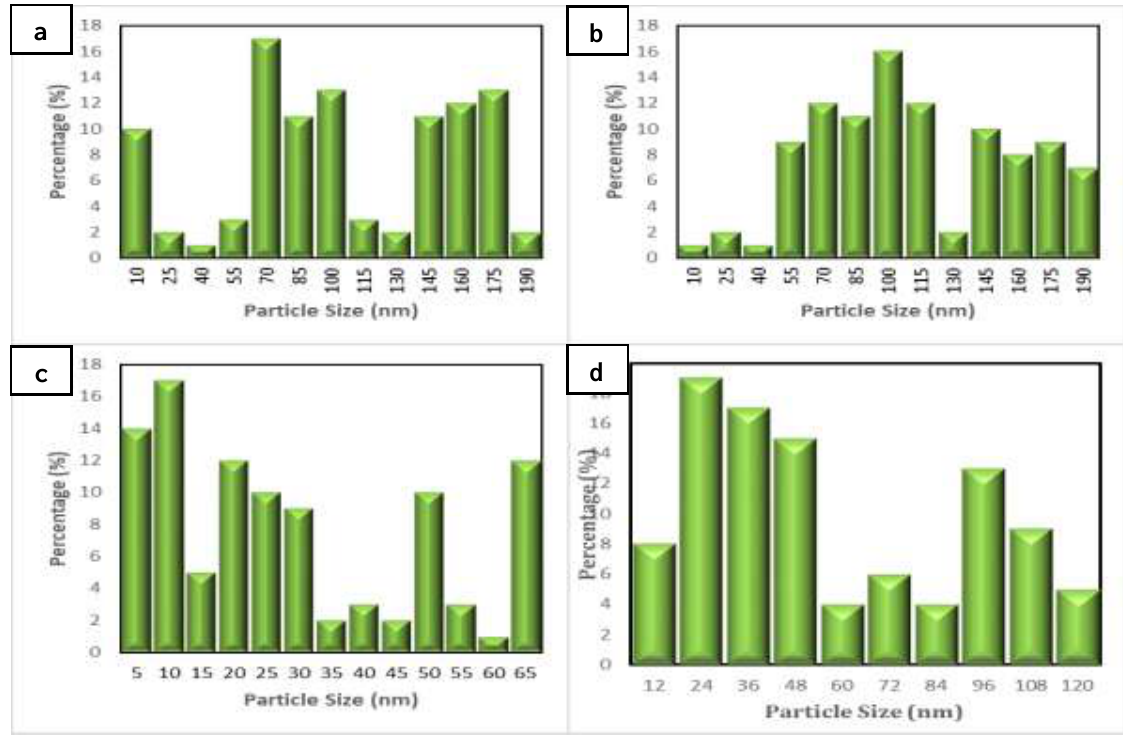
Figure 5: Histogram of Ti nanoparticles size at 5&10 min (a,b) on glass substrate and (c,d) on Si